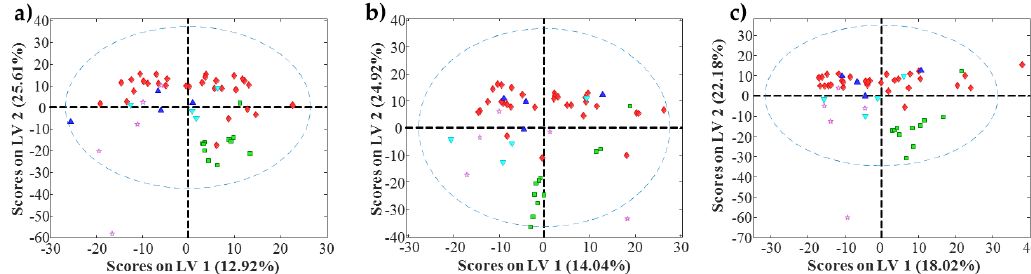
Figure 3. Partial Least Squares (PLS) scores plot for amide stationary phase. ( a ) Acid pH; ( b ) Moderately acid pH; ( c ) Neutral pH. Red diamonds are amino acids ( ♦ ), green squares are nucleosides ( ■ ), blue triangles are organic acids ( ▲ ), purple stars are sugars ( ★ ) and cyan triangles are others ( ▼ ).